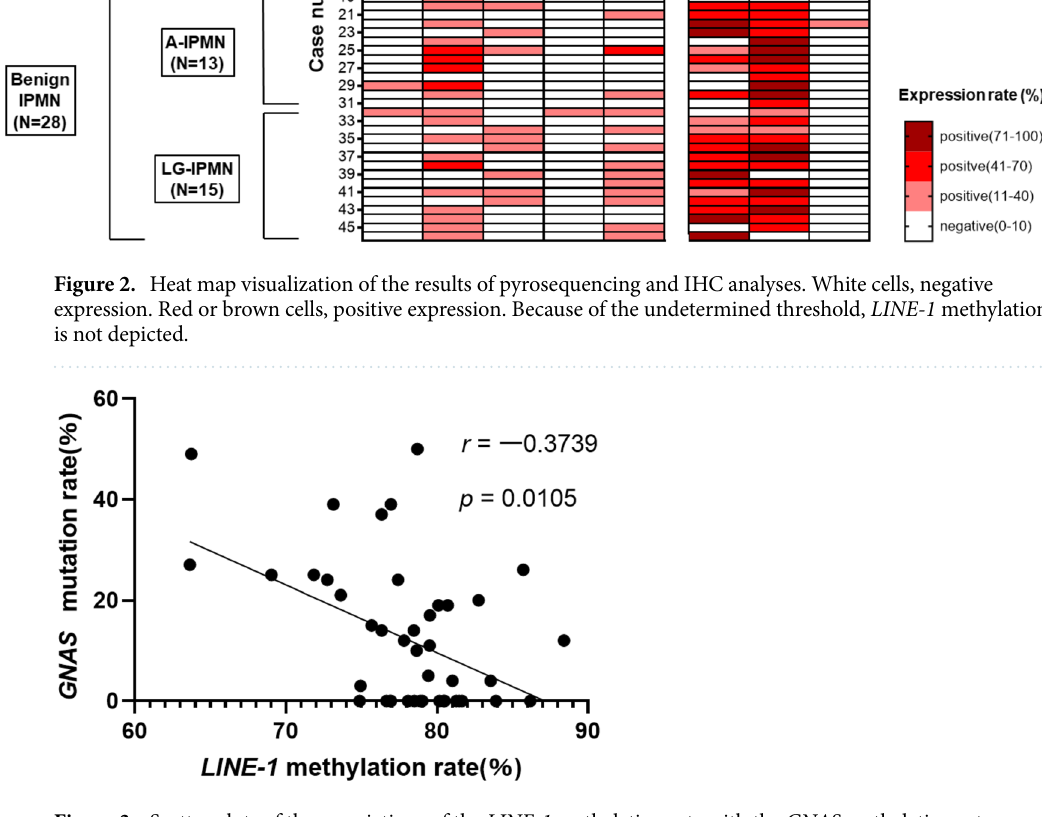
Figure 3. Scatter plots of the associations of the LINE-1 methylation rate with the GNAS methylation rate.